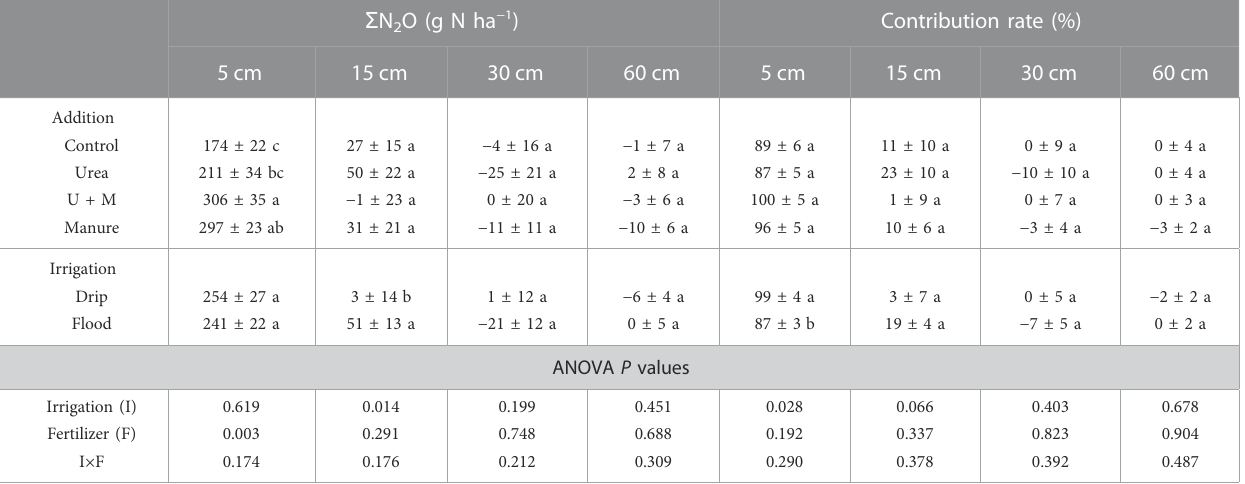
For each treatment factor, means within a column followed by the same letter are not signi fi cantly different at p <